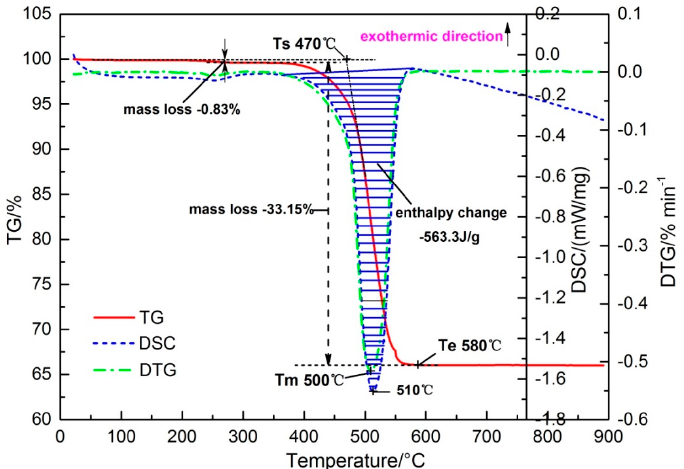
Figure 2. TG-DTG-DSC profiles of siderite sample in the neutral atmosphere.